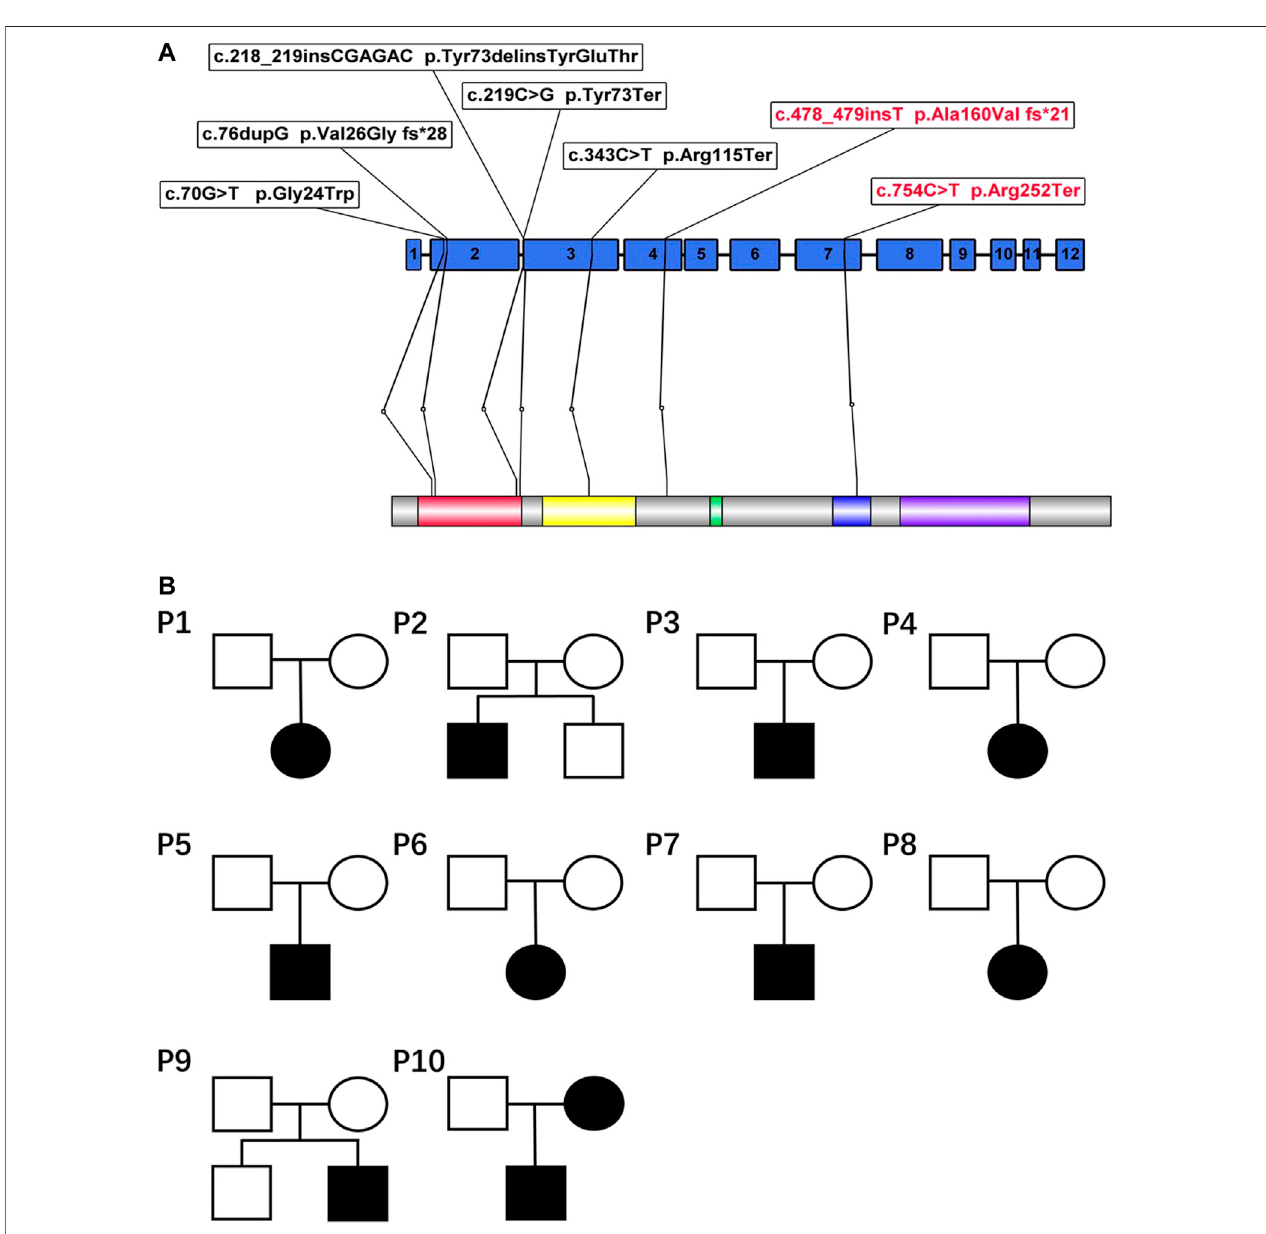
FIGURE2|(A) PAX2domain structureand localizationofsevenvariantsinthisarticle.Thevariantsmarkedwithredinthe fi gurerefertothenovelvariantsreported for the fi rst time. PAX2 is characterized by an N-terminal paired domain consisting of the N terminus (red) and C terminus (yellow). The relative locations of the other domains are also indicated, including the octapeptide motif (green), the homeodomain(blue), and a transactivation domain (violet). (B) Pedigrees of 10 families. The genetic variants of patient 10 originated from the mother, and his mother had clinical manifestations. The variant of patient 4 originated from her father, whose manifestations were not